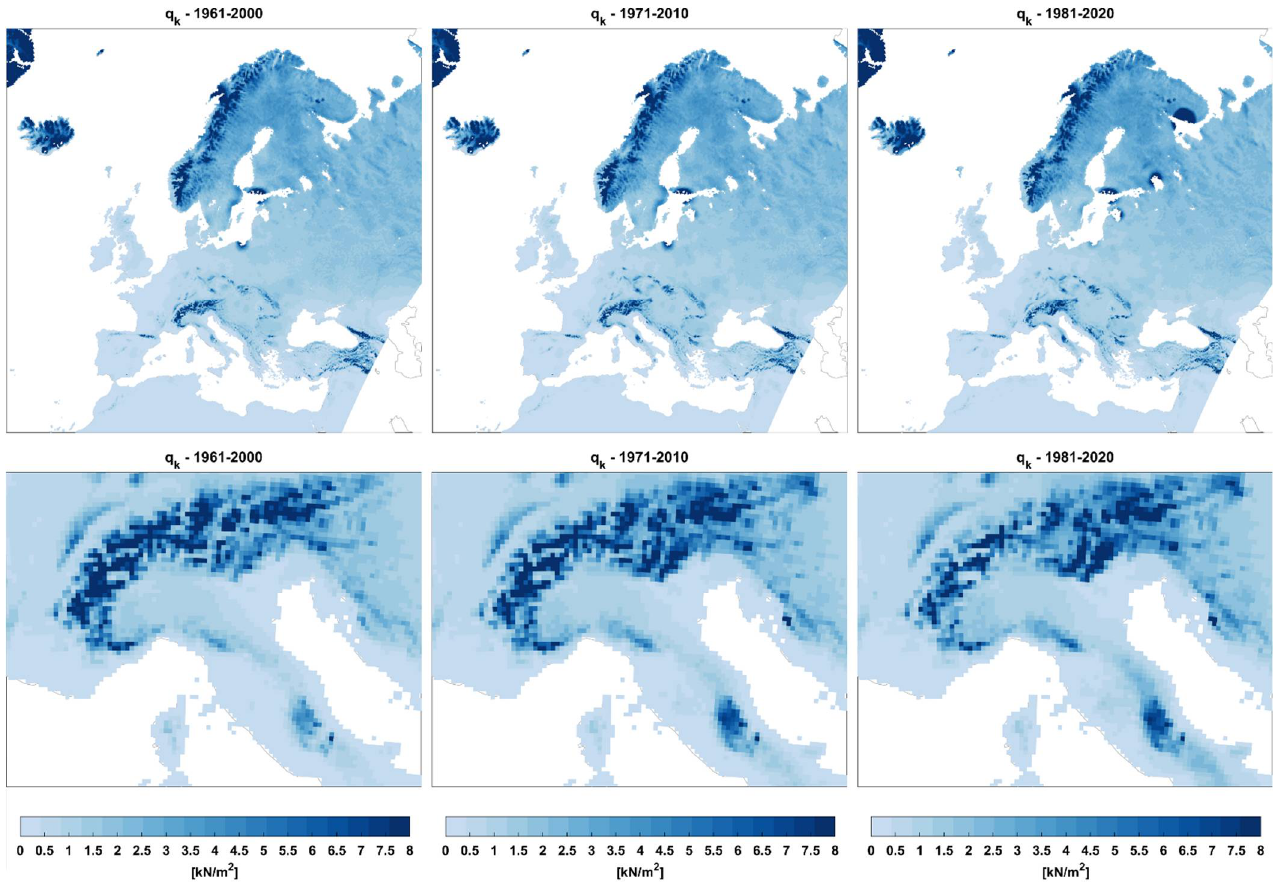
Figure 13. Maps of characteristic values of ground snow loads in Europe ( first row ) with a focus on northcentral part of Italy ( second row ) based on UERRA dataset in moving time windows (1961–2000, 1971–2010 and 1981–2020).